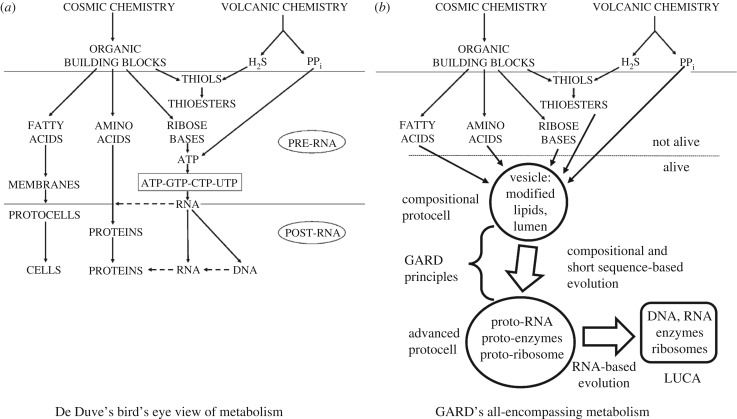
(a) Bird's eye view of protometabolism leading to life, published as tribute to Leslie Orgel by De Duve [217]. The scheme proposed conforms to the notion that the early chemistry of life, or protometabolism, must have prefigured present-day and GARD's System metabolism. The top part illustrates that two fundamental ingredients of life, inorganic pyrophosphate and hydrogen sulfide, both key energy transactions of present life, are likely to arise spontaneously in volcanic surroundings. Despite text descriptions of ATP as occupying a central position in all facets of protometabolism, the figure only shows its role in the advent of RNA. The scheme depicts protolife as involving three hardly interacting threads, with amino acids leading to proteins and fatty acids generating membranes. Disappointingly, protocells and cells are shown as an outcome of lipid membrane formation, without any shown relationship to the other two threads. Still, in line with what leads to the alternative scenario shown in b, De Duve states: ‘The early catalysts … cannot possibly have displayed the exquisite specificity of present-day enzymes and must necessarily have produced some sort of “dirty gemisch” … In particular, it is most unlikely that protometabolism could have happened by chance to generate just the two canonical pairs of complementary nucleotides. Such a fortunate coincidence smacks too much of prescience’. (b) In GARD's framework, the prelife period (not-alive) involves a plethora of abiotic paths that populate the planet with a very large assortment of compounds, including, but definitely not limited to the ones shown. We regard the separation of three threads in a as much less likely to have led to integrated protocells, precursors of the last universal common ancestor (LUCA). Instead, GARD and M-GARD paint a profoundly different picture, that of systems integration of some or all abiotic compounds into integral entities, that by the demonstrated GARD dynamics are capable of self-replication and rudimentary evolution, hence are alive by NASA's definition. The initial GARD assemblies would mostly just absorb amphiphiles from the environment and undergo primitive compositional replication. However, GARD's chemical opportunism would allow compositional protocells to emerge that include catalytic and high-energy amphiphiles to generate a replicating protometabolism as described under the M-GARD title. In a very long series of evolutionary events, but in principle kinetically traceable, complexity would increases towards producing primitive versions of templating oligomers (proto RNA [243]), as well as protein-based protoenzymes and even proto-ribosomes [244,245]. This scenario would make it much less necessary for early life to depend on the less efficient ribozyme catalysis. Additional eons of evolution would lead to LUCA, with full-fledged cellular machinery that will eventually win numerous selection bottleneck battles, becoming dominant in further evolution.